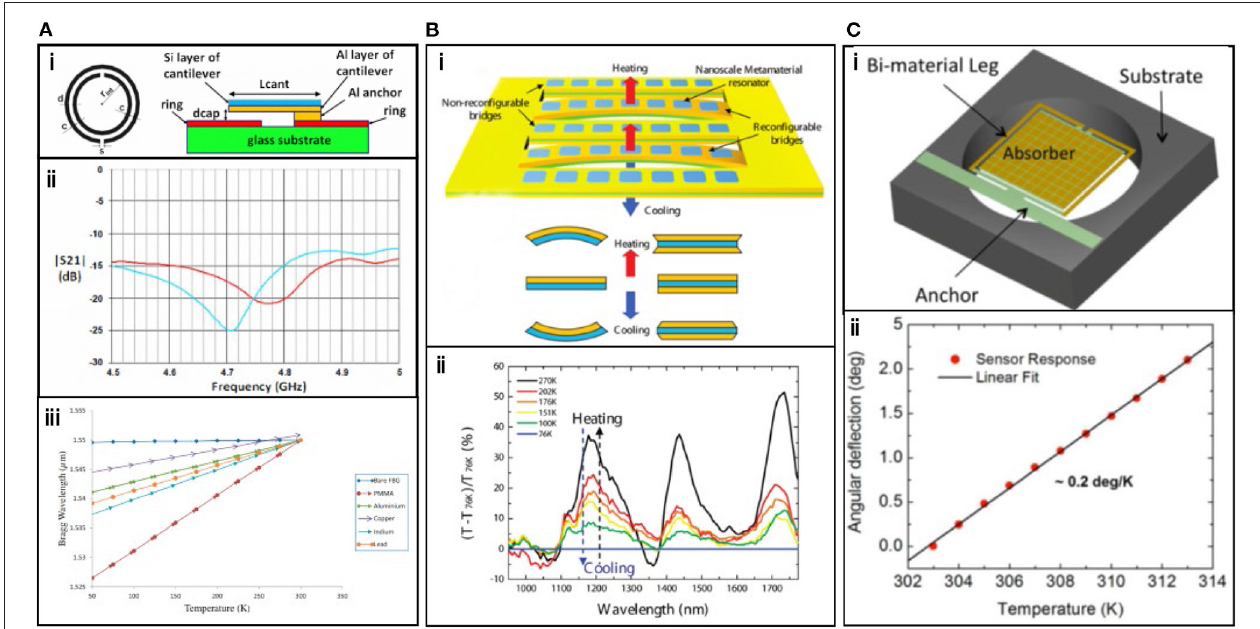
FIGURE 1 | Temperature sensitivity metamaterial units. (A) SRR on a cantilever arm, and the transmission spectra and resonant frequency response under different temperatures [ 38, 50], (B) nanoscale reconfigurable photonic metamaterials and the corresponding temperature changing performances [51], (C) Metamaterial absorber configuration fabricated on a microcantilevers and the accordingly temperature changing inspired structure deformation performance